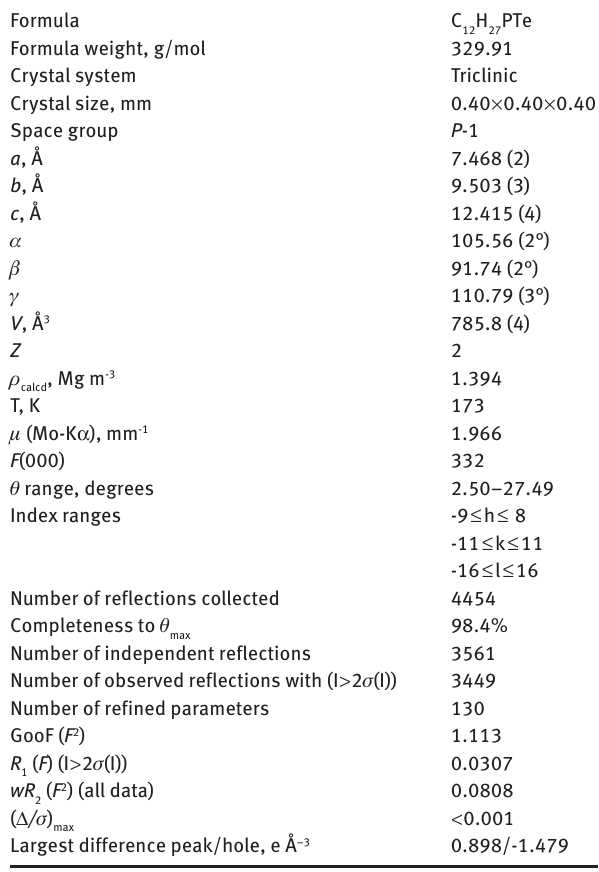
Table 1 Crystal data and structure refinement of n -Bu